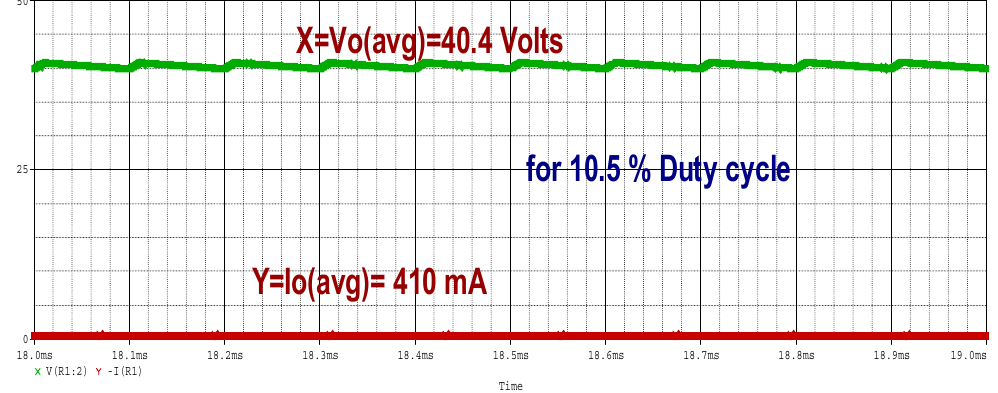
Figure 20. Waveforms for output capacitor current and output load current.